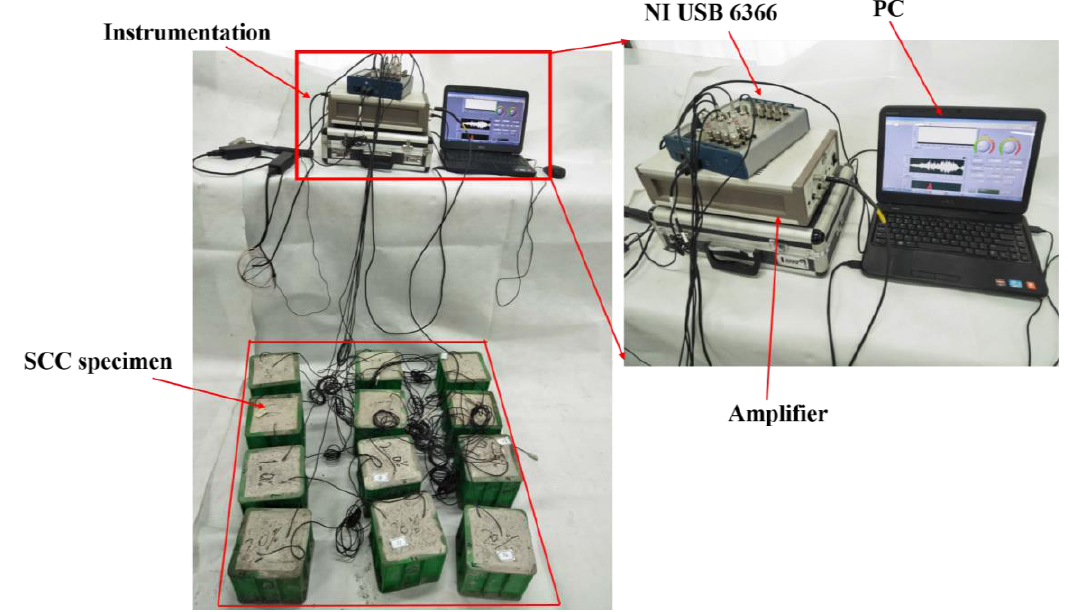
Figure 10. Instrumentation for smart aggregate (SA) based active sensing approach.